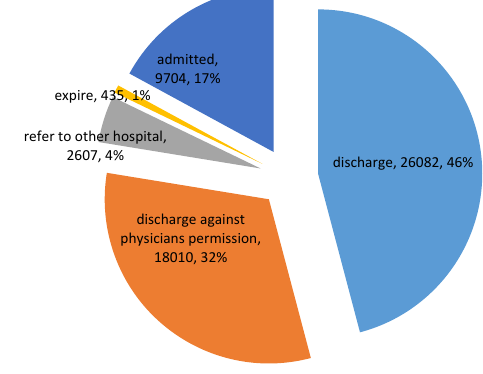
Figure 1. Frequency of patients’ final fate.